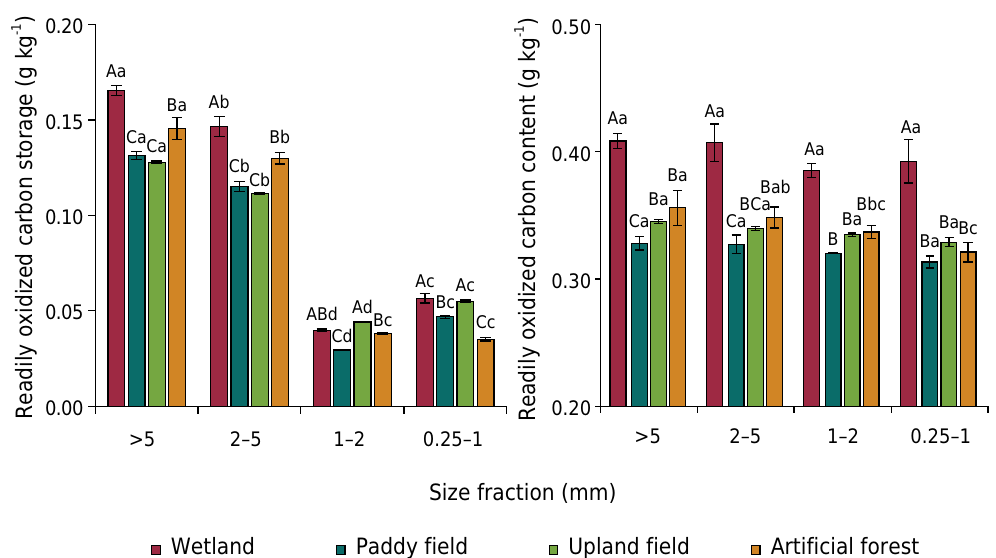
Figure 6. Content and storage of readily oxidized carbon in soil aggregates under different land-use types in the Sanjiang Plain wetlands. Capital letters represent the differences between different land-use types at the same soil aggregates. Lowercase letters represent the differences of the same land-use type in different soil